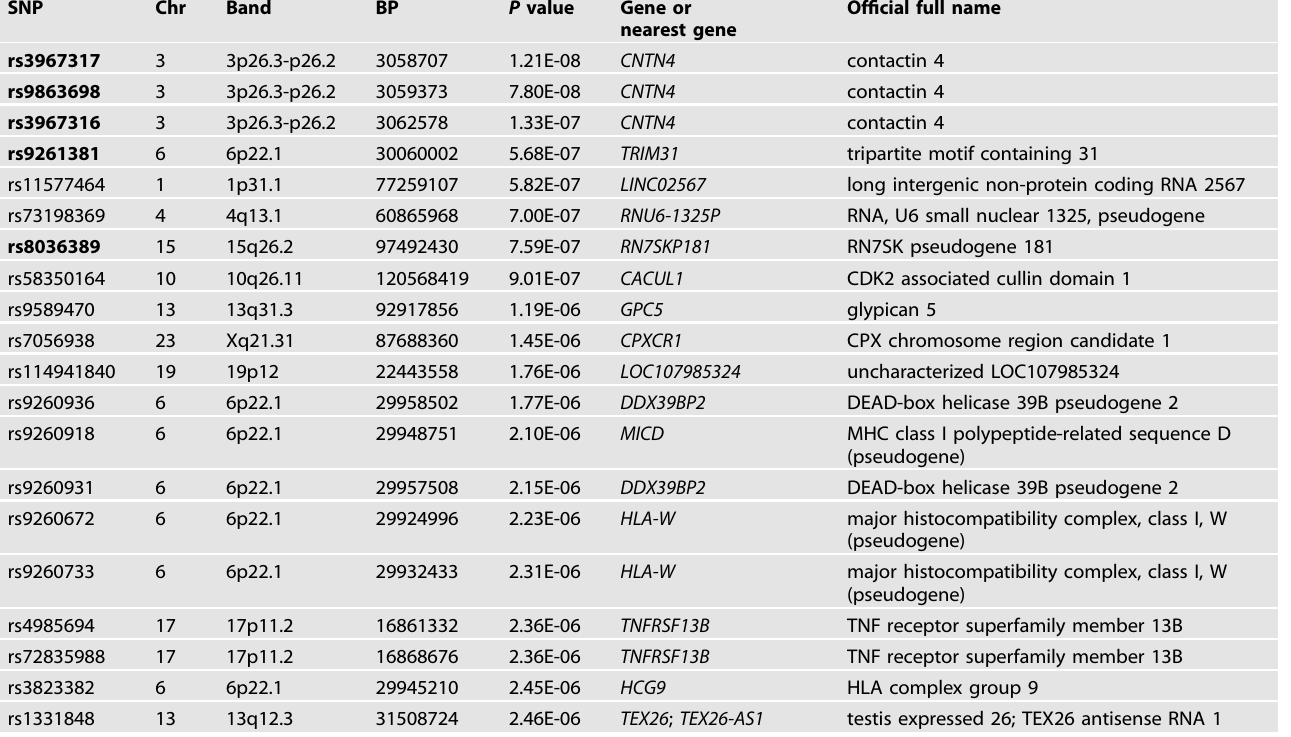
Table 1. The top 20 SNPs from multivariate GWAS of